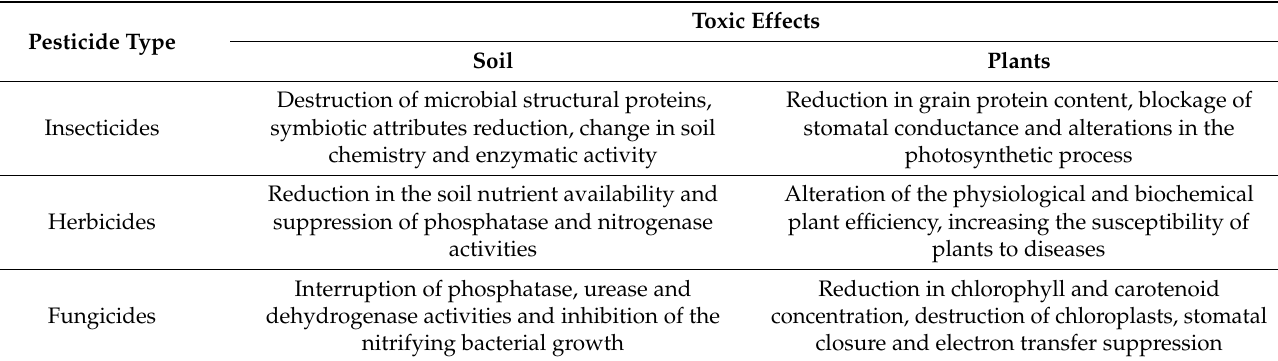
Table 3. Toxic effects of pesticides on agricultural soils and plants.